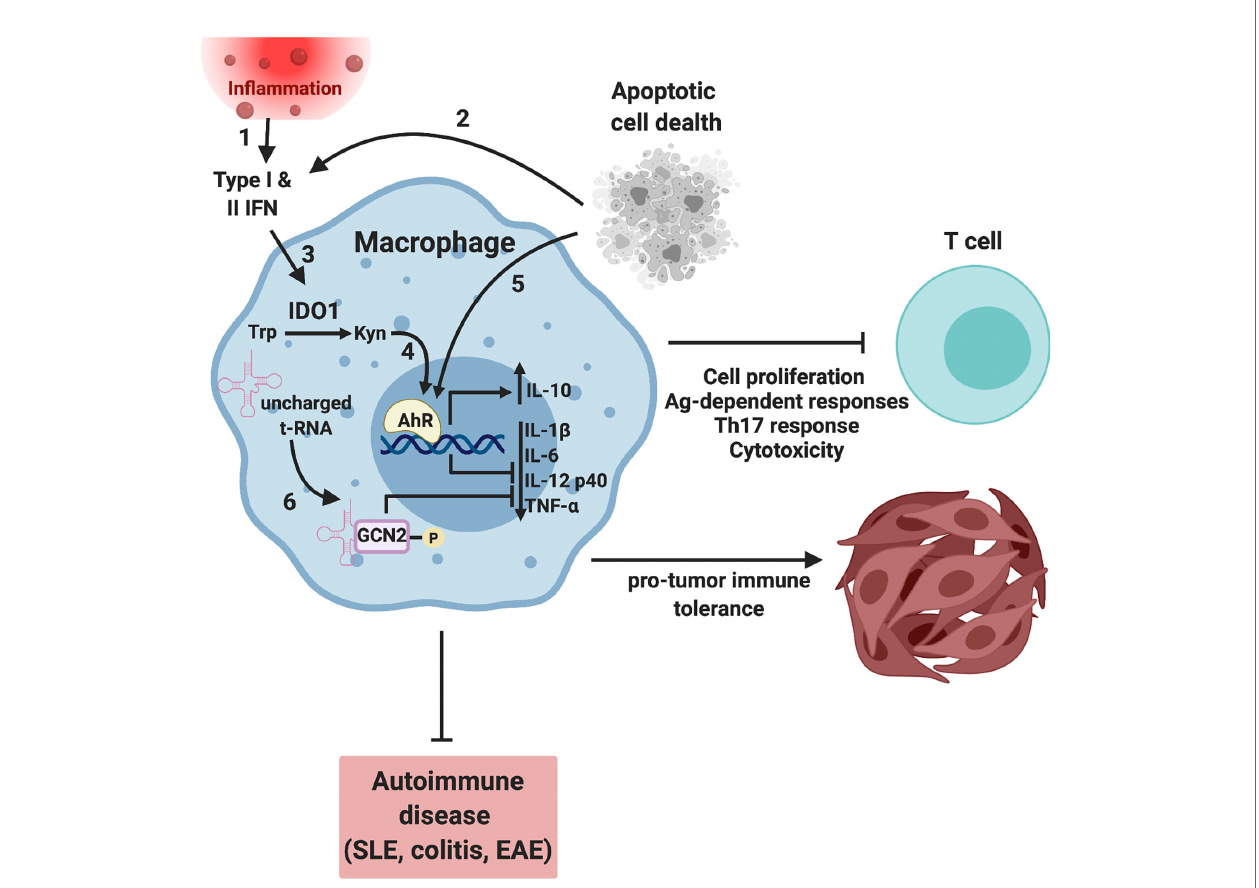
FIGURE 2 | Tryptophan metabolism regulates macrophage function by AhR and GCN2-dependent mechanism. In fl ammation (1) and/or apoptotic cell phagocytosis (2) induces interferon expression that drives expression of the interferon responsive gene (ISG) IDO1 (3). IDO-dependent enzymatic consumption of tryptophan results in the accumulation of tryptophan catabolites such as L-kynerunine that bind to and activate the transcription factor AhR (4), driving a tolerogenic macrophage phenotype. In addition, apoptotic cells can activate AhR in an IDO-independent, TLR9-dependent mechanism (5) (3). In parallel, amino acid starvation results in increased uncharged tRNAs and translational stress driving activation of GCN2 (6). GCN2 activity drives a more regulatory, less in fl ammatory macrophage phenotype suppressingT cellactivation,proliferation, andTh17 responses. In the context of autoimmune disease such as lupus, colitisand autoimmune encephalomyelitis (EAE),decreased in fl ammation results ina more favorable disease outcome with less severe symptomsand increased survival(4, 33 – 36). Conversely,aminoacid depletion results in a tolerogenictumor immune microenvironment, tumorgrowth and decreased survival (37).Image created using